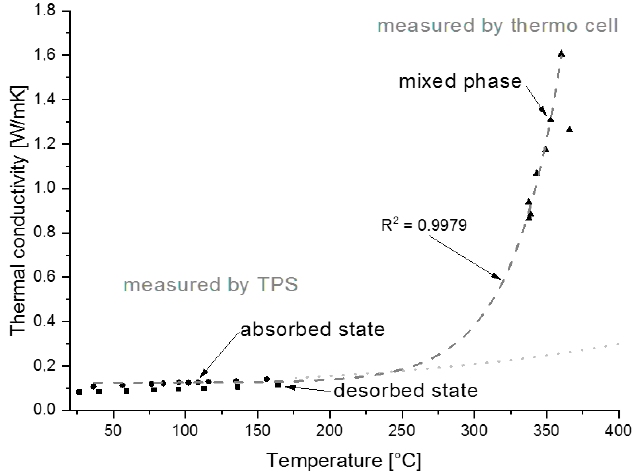
Figure 8. Variation of the thermal conductivity with increasing temperature measured ex situ by TPS method at elevated temperature (up to 180 °C under Ar) and in situ by thermocell at even higher temperatures (up to 360 °C in H 2 atmosphere).